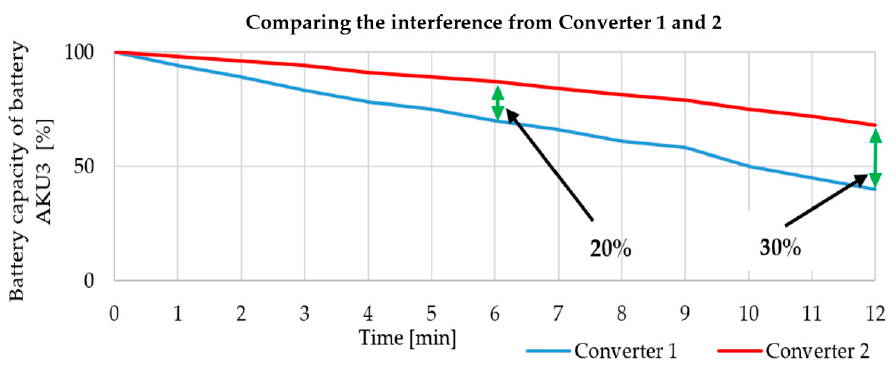
Figure 26. Comparison of interference by converter 1 and 2.